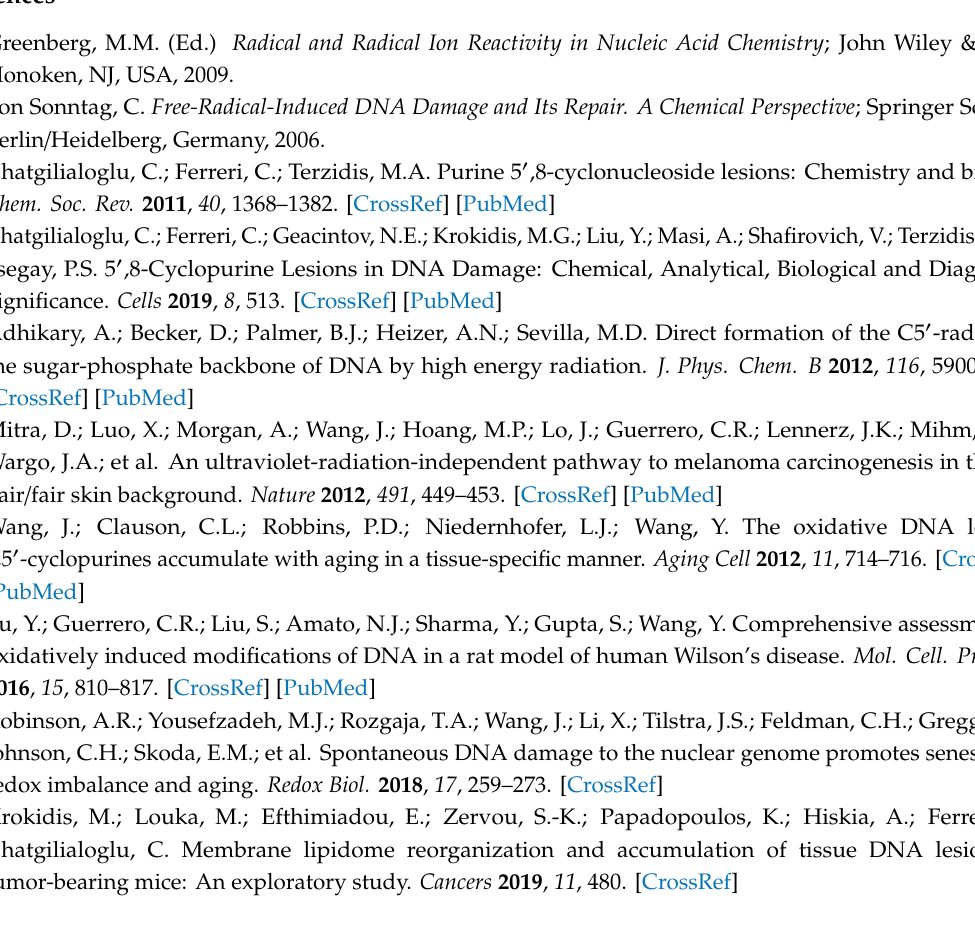
Table S1: A list of MRM transitions, Table S2: Total amount of cPu and 8-oxo-Pu in DNA applying Procedure (i), Table S3: Total amount of cPu and 8-oxo-Pu in DNA applying Procedure (ii), Table S4: The levels cPu and 8-oxo-Pu in ct-DNA DNA, Table S5: Sequences and molecular masses of the synthesized ODNs, Table S6: Total amount of cPu and 8-oxo-Pu in double-stranded 21-mer oligonucleotides, Table S7: The levels of cPu and 8-oxo-Pu upon Fenton-type reagent treatment of ds-ODNs, Table S8: Total amount of 8-oxo-purine lesions and cPu lesions upon Fenton-type reagent treatment of ds-ODNs, Table S9. The diastereoisomeric ratios (5 (cid:48) R / 5 (cid:48) S ) for both cdG and cdA upon Fenton-type reagent treatment of ds-ODNs, Table S10: The levels of cPu and 8-oxo-Pu upon treatment of ds-ODNs with Fenton-type reagents (copper), Table S11: Total amount of 8-oxo-purine lesions and cPu lesions formation upon treatment of ds-ODNs with Fenton-type reagents (copper), Table S12: The diastereoisomeric ratios (5 (cid:48) R / 5 (cid:48) S ) for both cdG and cdA upon treatment of ds-ODNs with Fenton-type reagents (copper), Table S13: The levels of cPu and 8-oxo-Pu upon treatment of ds-ODNs with Fenton-type reagents (iron), Table S14. Total amount of 8-oxo-purine lesions and cPu lesions formation upon treatment of ds-ODNs with Fenton-type reagents (iron), Table S15: The diastereoisomeric ratios (5 (cid:48) R / 5 (cid:48) S ) for both cdG and cdA upon treatment of ds-ODNs with Fenton-type reagents